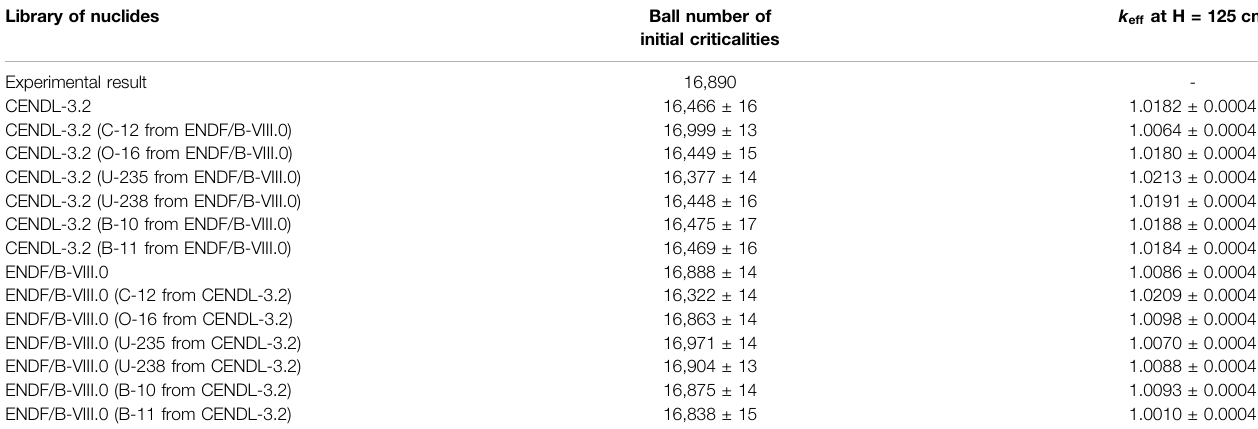
TABLE 5 | Comparison to identify the nuclide causing major impact.